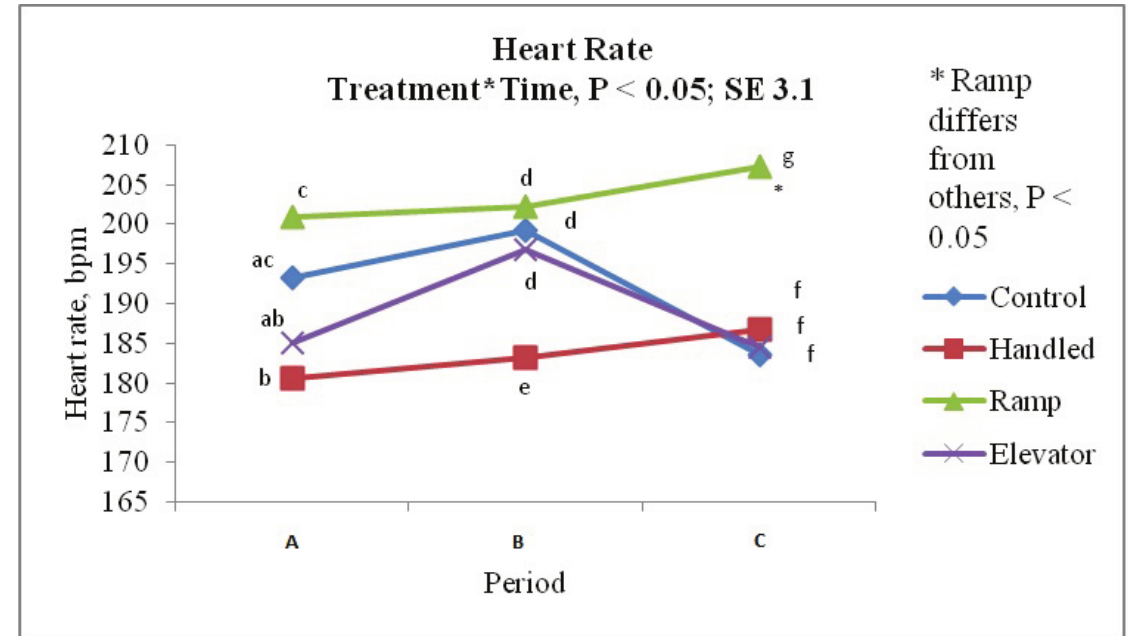
Figure 5. The heart rate (beats per min) of pigs an hour before, during and after each treatment (control, handling, ramp and